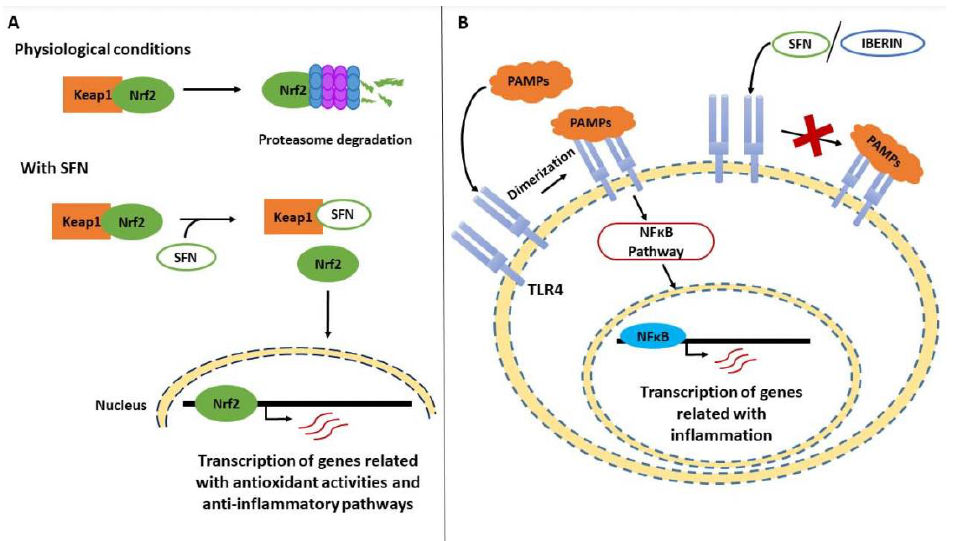
Figure 1. Effect of Brassicaceae bioactives compounds upon the transcription of genes related with inflammation. ( A ) In physiological conditions, Keap1 promotes the degradation of Nrf2 by the proteasome. However, when sulforaphane (SFN) interacts with Keap1 by binding its cysteine residues, Nef2 is released and translocated to the nucleus. In this way, Nrf2 up regulates the transcription of genes related with antioxidant activities and anti-inflammatory pathways. ( B ) In an inflammatory process, Toll-like receptor 4 (TLR4) undergoes dimerization after recognizing pathogen-associated molecular patterns (PAMPs), activating the NFκB pathway and up-regulating genes related with inflammation. When SFN and iberin interact with TLR4, it cannot oligomerizate, and the inflammatory response is inhibited.